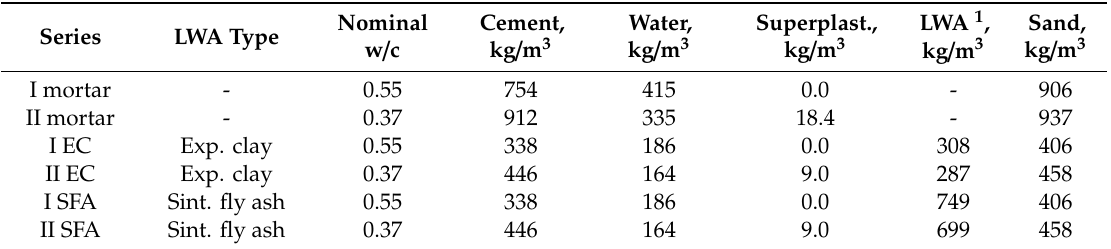
Table 2. Compositions of mortars and lightweight concretes. LWA, lightweight aggregate; EC, expanded clay; SFA, sintered fly ash.